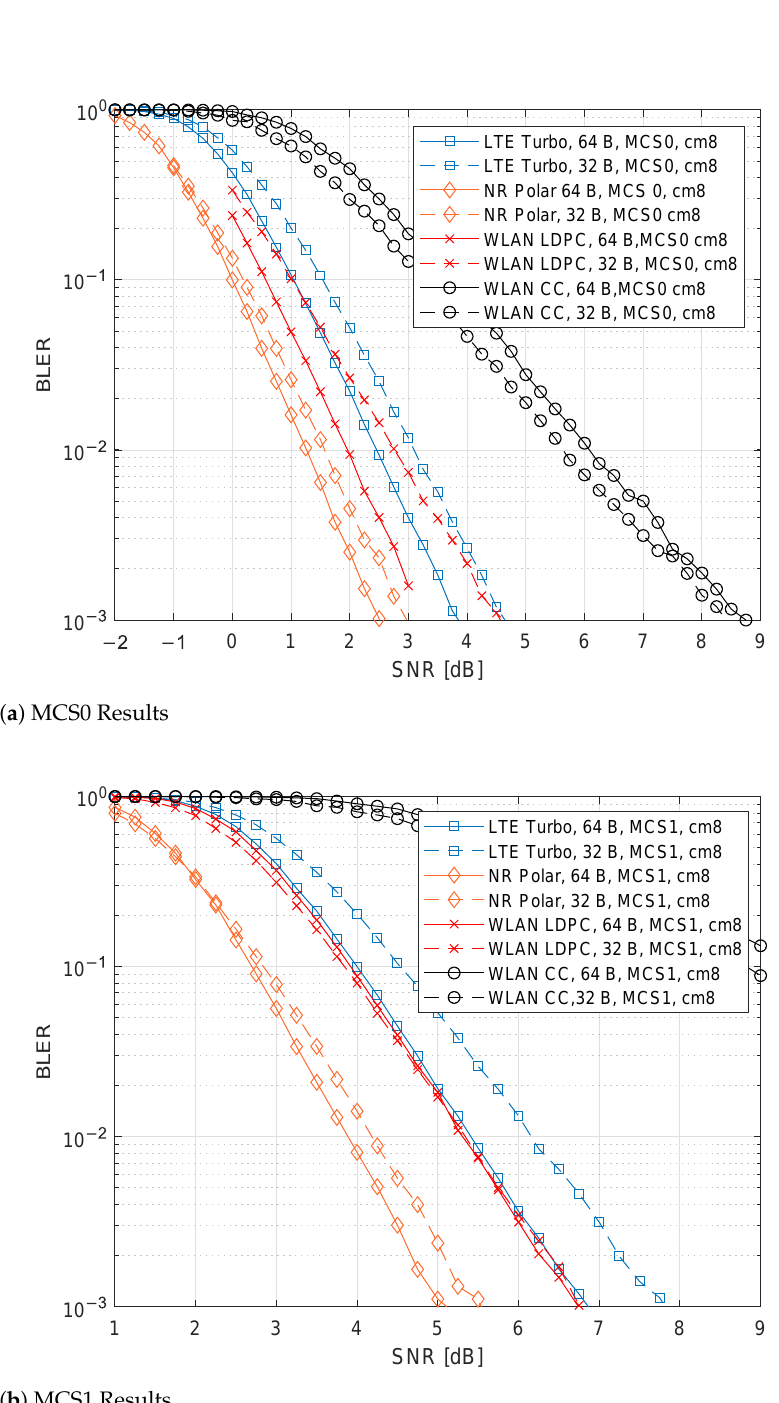
Figure 9. Comparison of the different channel coding techniques for CM8